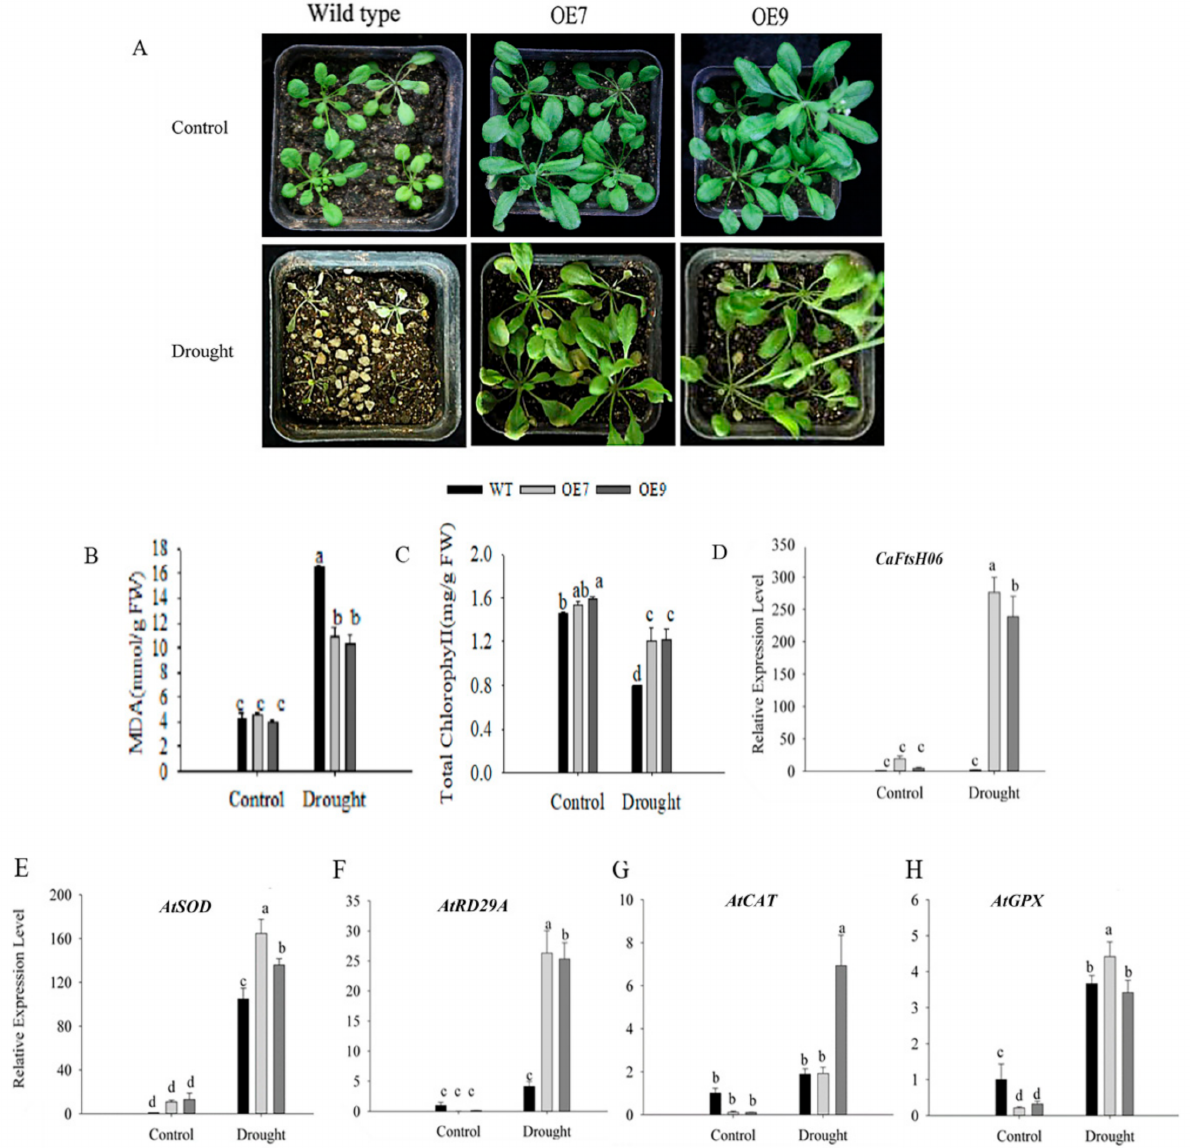
Figure 12. Drought stress tolerance analysis of wild-type (WT) and transgenic CaFtsH06-expressing Arabidopsis seedlings. ( A ) Phenotypes of WT and CaFtsH06-expressing Arabidopsis seedlings following the withholding of water for seven days. ( B , C ) MDA content and total chlorophyll content of CaFtsH06-expressing and WT Arabidopsis plants. The drought stress was applied by not watering the seedlings for seven days. ( D – H ) The transcript levels of genes related to drought stress in the transgenic and WT Arabidopsis plants. Different letters denote statistical significance ( p <